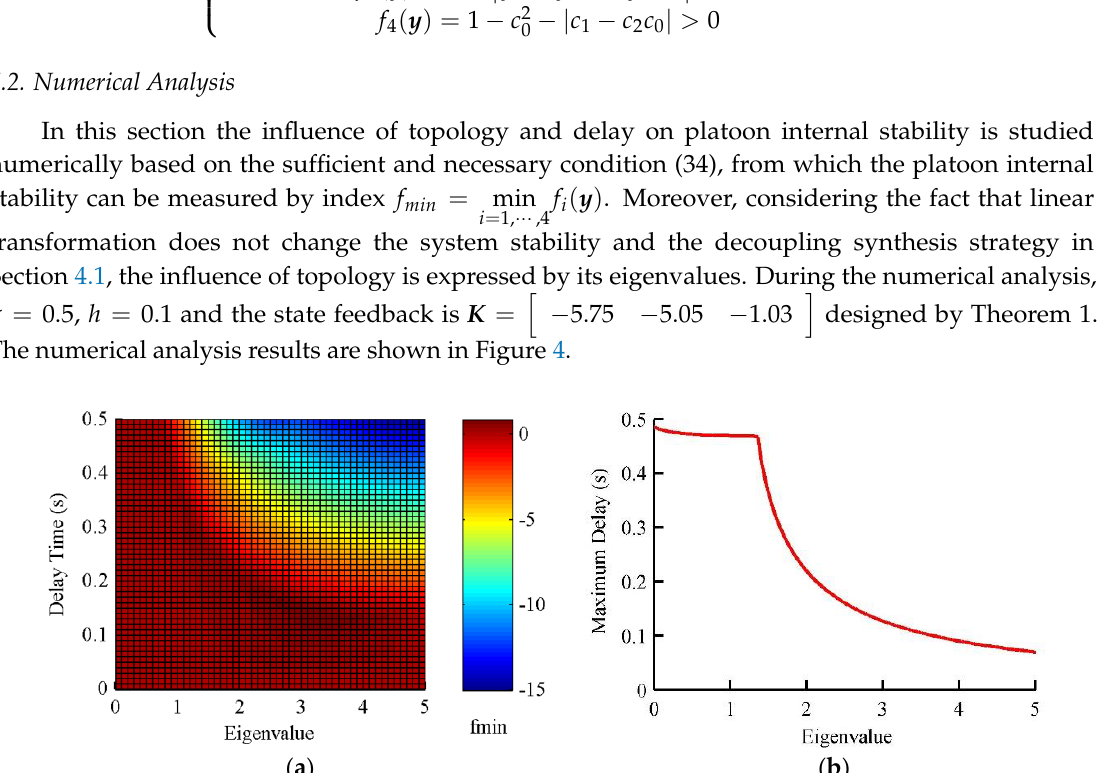
Figure 4. Influence of delay and topology on internal stability. ( a ) Results of 𝑓 𝑚𝑖𝑛 . ( b ) Allowable communication delay.